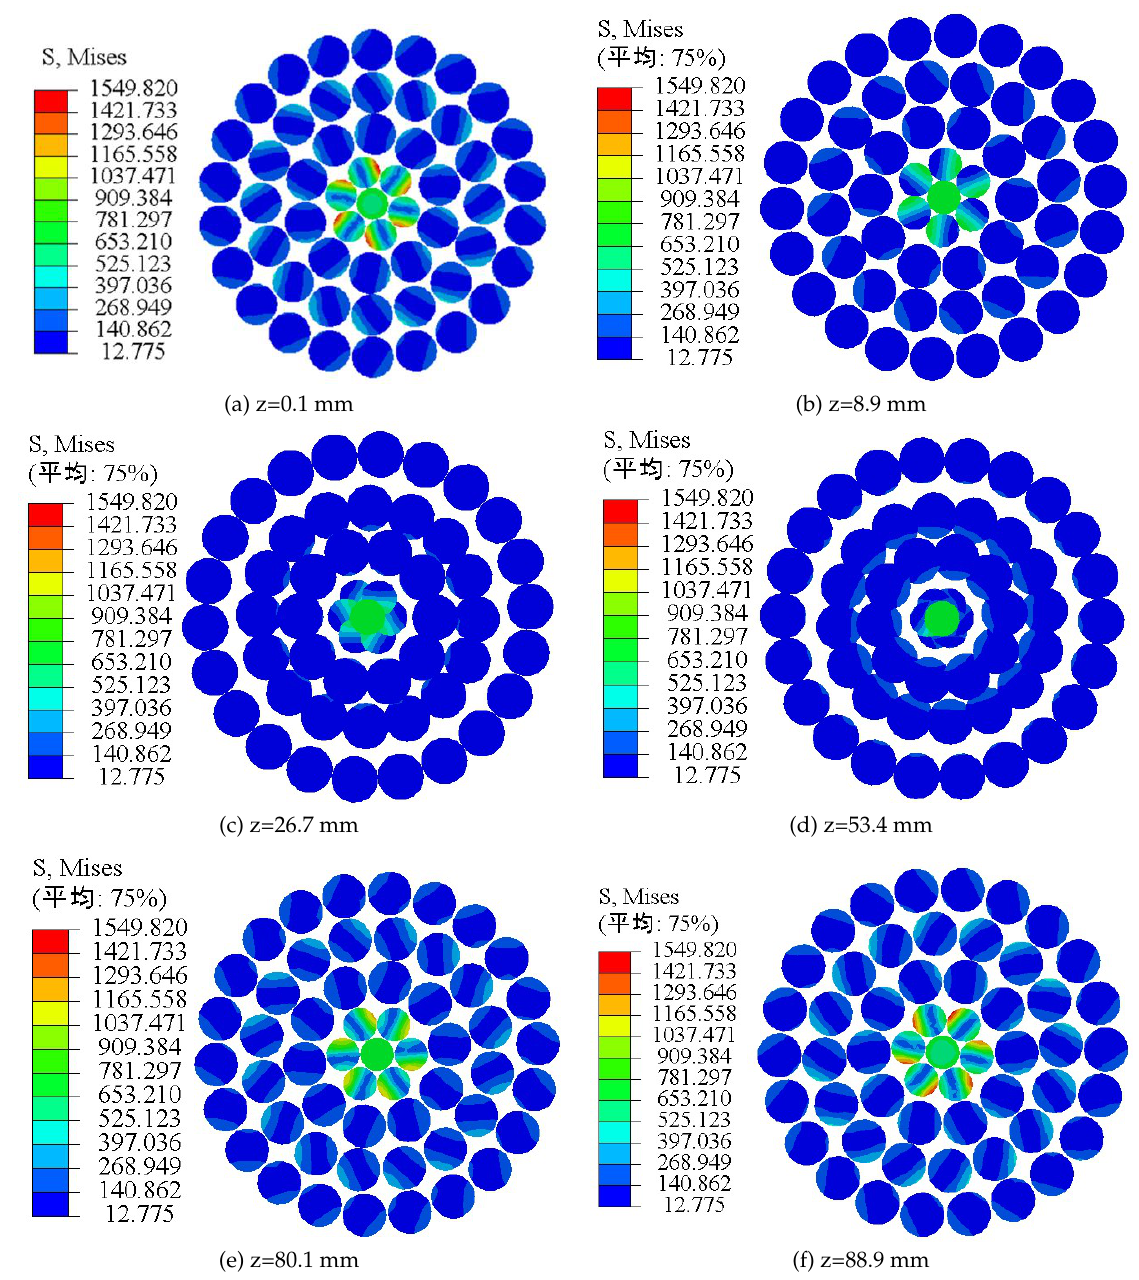
Fig. 11. Section of equivalent stress of positive feeder under 25%